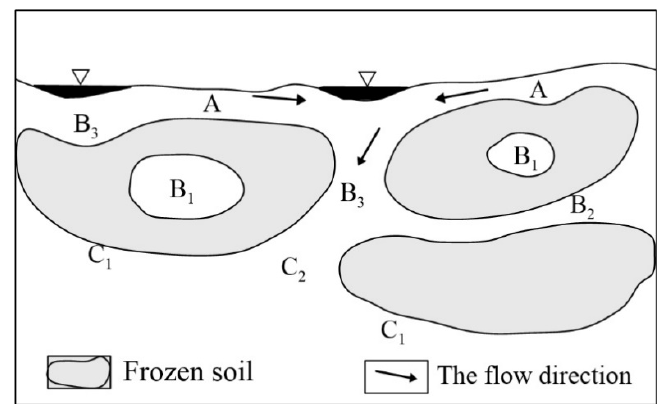
Figure 4. Schematic of groundwater types in permafrost areas [25]: (A) upper permafrost water; (B1) water in middle permafrost; (B2) water between permafrost layers; (B3) channel water of freeze–thaw zone; (C1) direct contact water in bottom permafrost; (C2) non-direct-contact water in bottom permafrost.